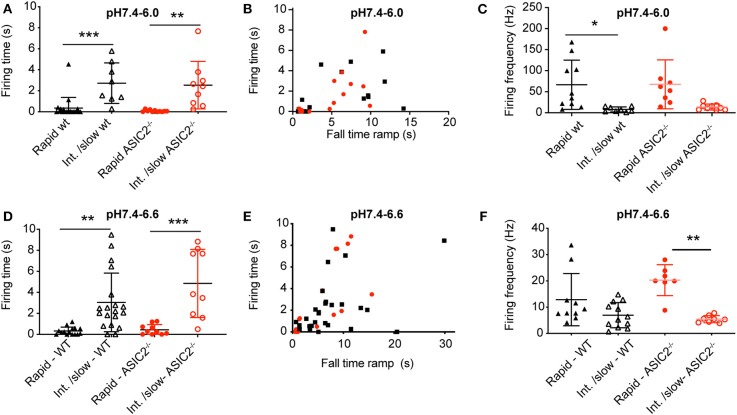
Analysis of acid-induced action potential firing in cultured cortical neurons. The experimental conditions were as described in the legend to Figure 6. (A,D) Firing time, calculated as the duration between the beginning of the first and the end of the last AP in AP bursts, plotted for pH 7.4–6.0 ramps (A) and pH 7.4–6.6 ramps (D) with ramp FT < 4 s (rapid) and >4 s (Int./slow), n = 8–20. Only experiments with at least one AP were considered. (B,E) Firing time, plotted as a function of the pH ramp FT, for pH 7.4–6.0 ramps (B) and pH 7.4–6.6 ramps (E), n = 14–22. (C,F) AP firing frequency, calculated as AP number/firing time, for pH 7.4–6.0 (C) and pH 7.4–6.6 ramps (F), n = 7–12. *p < 0.05; **p < 0.01; ***p < 0.001, different between the indicated conditions. Statistical tests were Kruskal-Wallis and Dunn's post-hoc test for A and F, ANOVA and Tukey post-hoc test for (C,D).